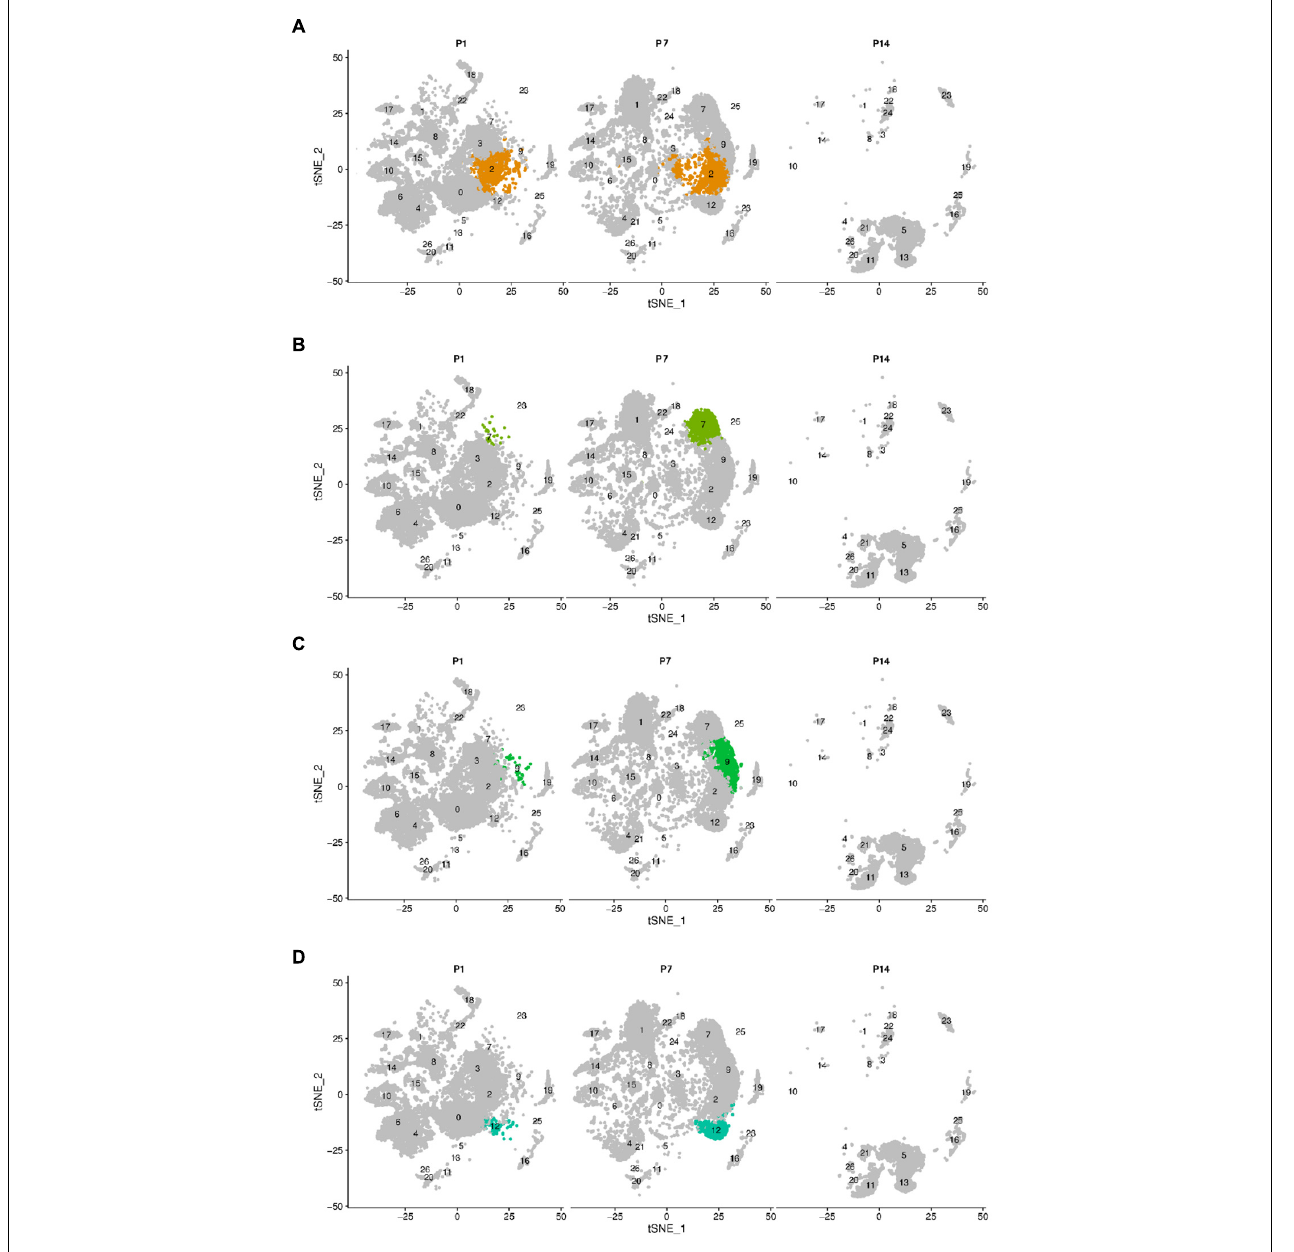
FIGURE 2 | The change of cell number of the above different cell clusters in three different periods of P1, P7, and P14. Cells were clustered using a graph-based shared nearest-neighbor clustering approach plotted by a tSNE plot. (A) tSNE plot of Cluster 2. (B) tSNE plot of Cluster 7. (C) tSNE plot of Cluster 9. (D) tSNE plot of Cluster 12. Clusters 2, 7, 9, and 12 showed an increase in the number of cells from P1 to P7, while degenerated and disappeared at P14